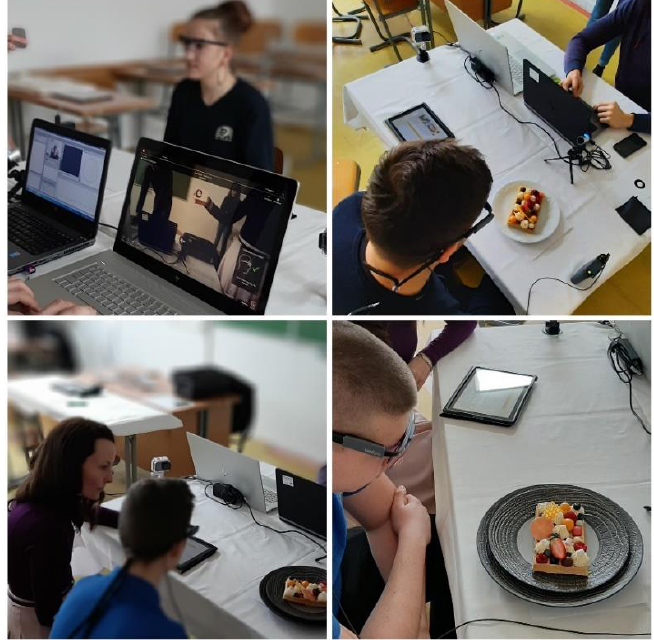
Figure 2. The course of testing the visual design of waffles.